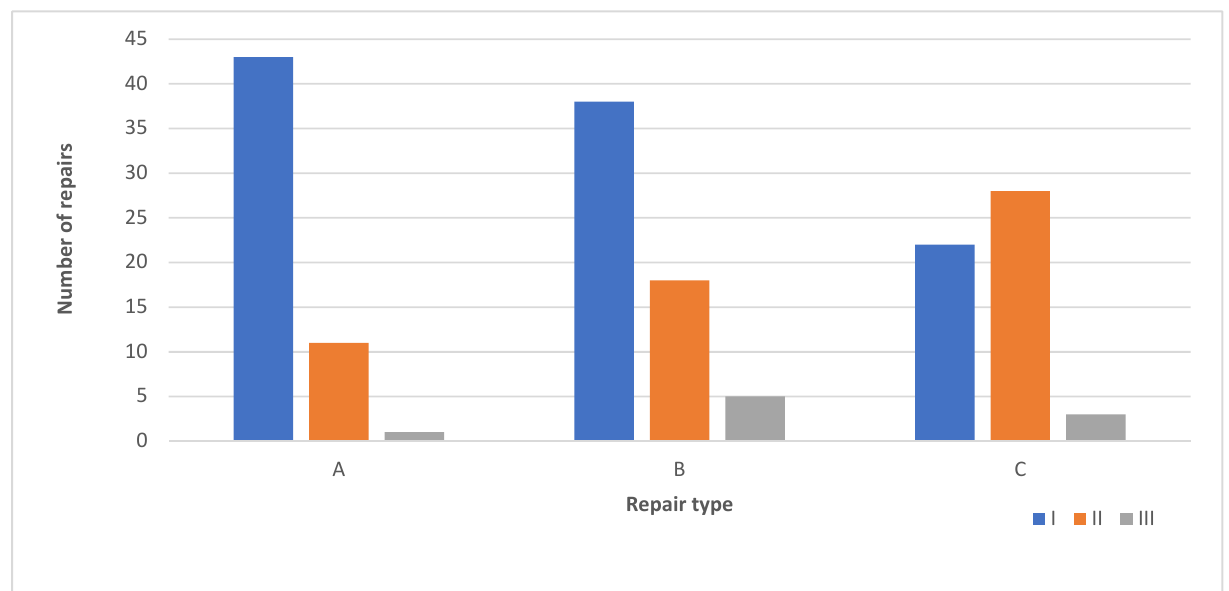
Figure 9. Repairs of A, B and C elements performed over the shifts (I, II, III). Table 1. Results of association rule.